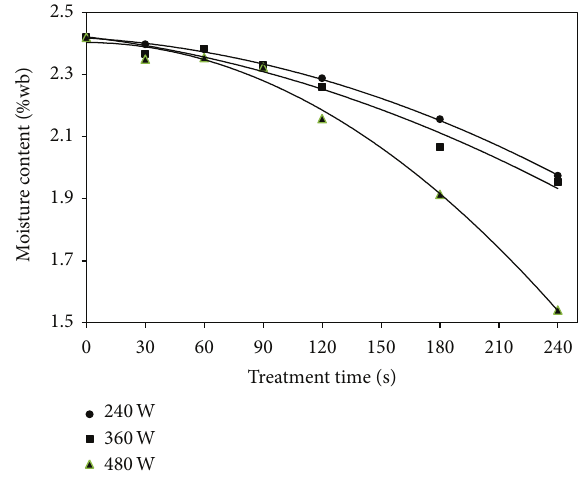
Figure 1: Variation of moisture content with exposure time for dif- ferent power levels of cashew